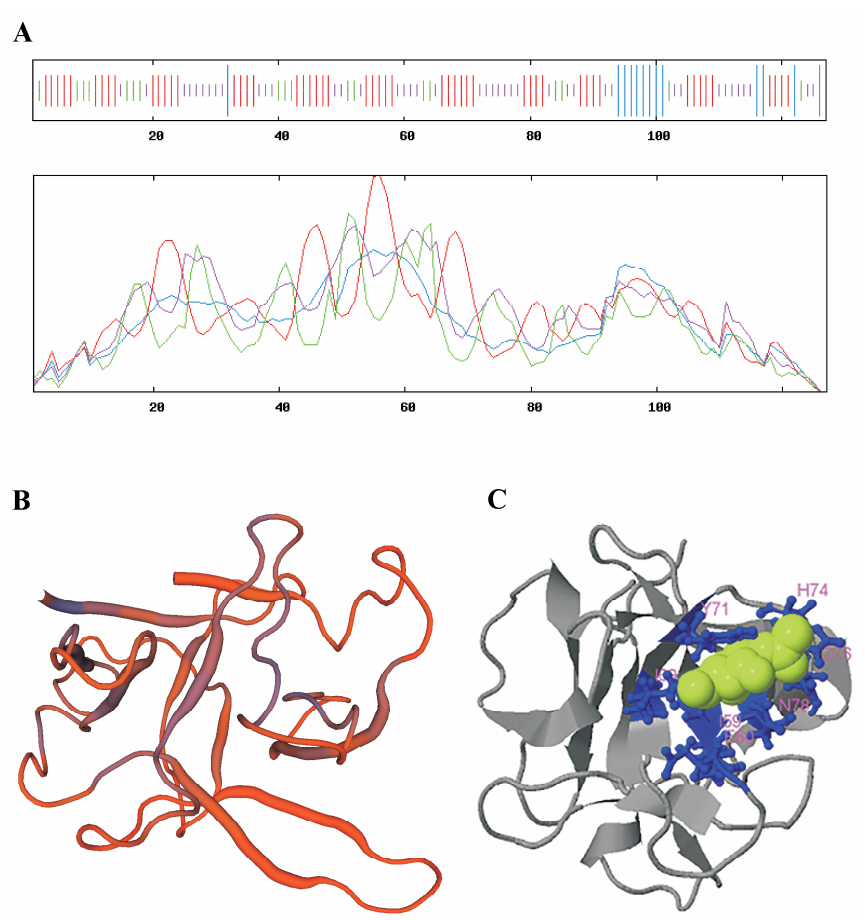
Figure 2. ( A ) Predicted secondary structure of the LdRBLk protein in the online SOPMA program. Strokes and lines are Strokes and lines are shown in blue, red, green and purple, representing an alpha helix, an shown in blue, red, green and purple, representing an alpha helix, an extended strand, a beta turn and a random coil, respectively. Predicted tertiary structure of the LdRBLk peptide. ( B ) QMEAN color scheme constructed by SWISS-MODEL homology modeling. ( C ) Prediction of the ligand binding site for the LdRBLk peptide by the I-TASSER program.